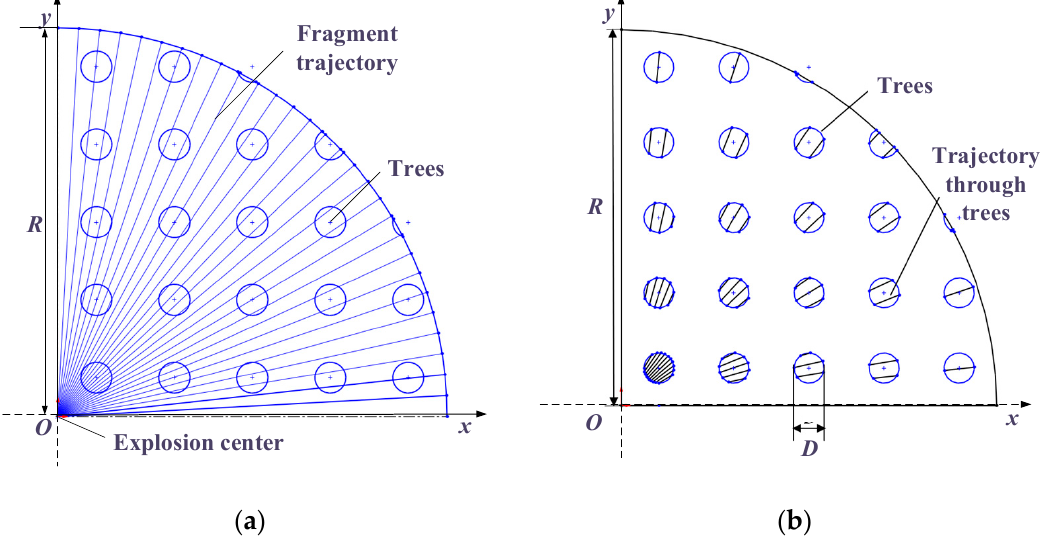
Figure 6. A model for the uniform dispersion of fragments in forests.(1/4 model) ( a ) is schematic diagram of evenly scattered fragments; ( b ) is penetration trajectory through trees.